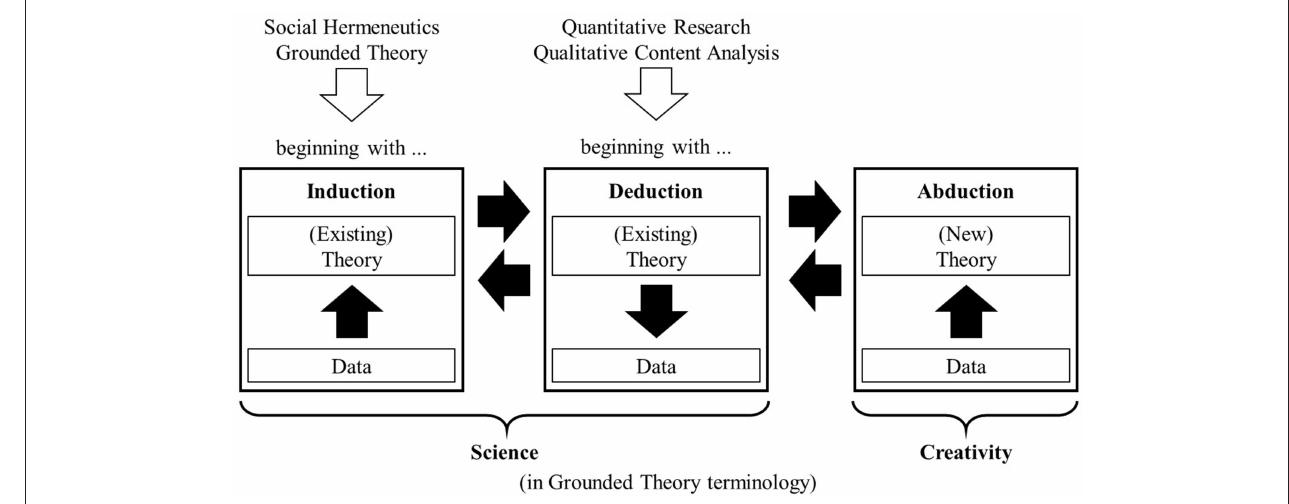
FIGURE 1 | Induction, deduction, and